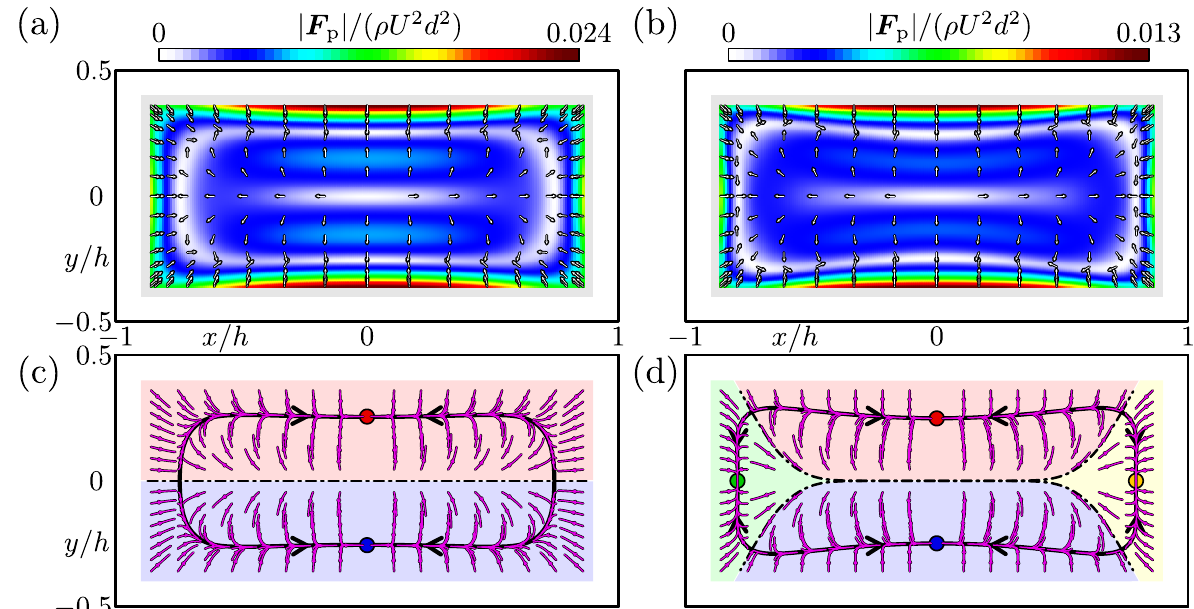
Figure 3. ( a , b ) Lift-force maps of the duct cross-section. Each arrow represents the inertial lift force acting on a particle located at its origin. The coloured background is the magnitude of the lift force. The region of existence of the particle centre is depicted by a grey colour in the cross-section. ( c , d ) Trajectories of the particle centre projected over the cross-section (curves with arrows) and particle-focusing points (circles). Suspended particles located in each coloured region move towards the focusing point with the corresponding colour. The trajectories drawn by thick curves are called pSS ring [9]. Dash-dotted curves represent the separatrices. A = 2, d / h = 0.2. ( a , c ) Re = 50, ( b , d ) Re =